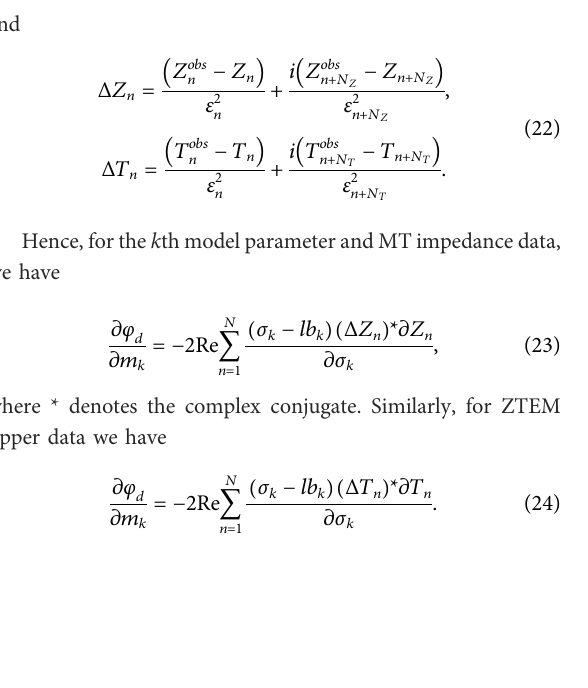
Frontiers in Earth